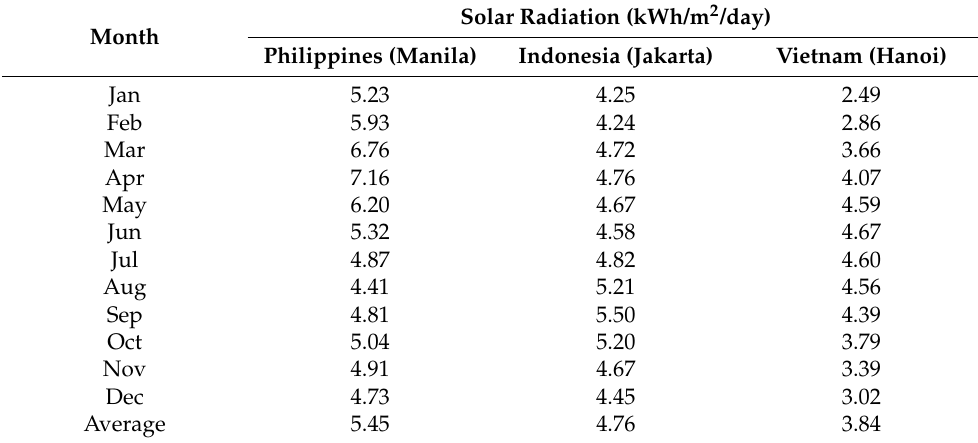
Table 8. Average annual solar radiation in the three